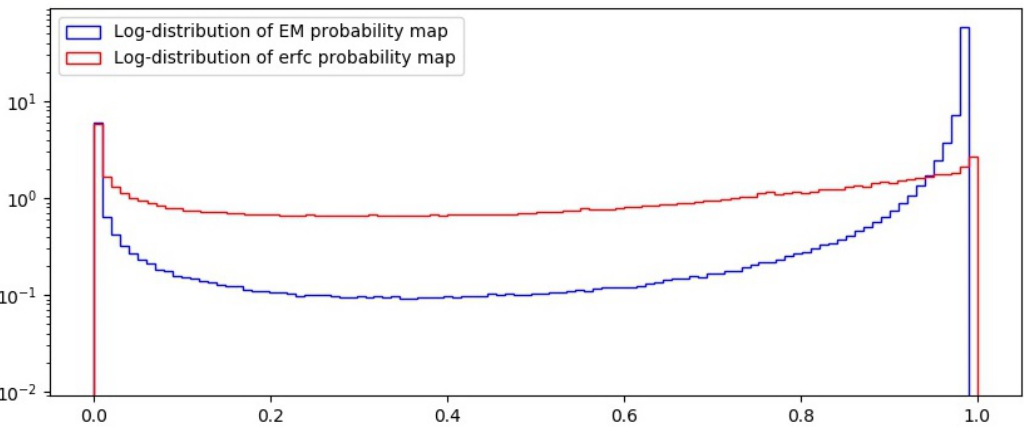
Figure 9. Frequencies for probabilities of interpolated and acquired